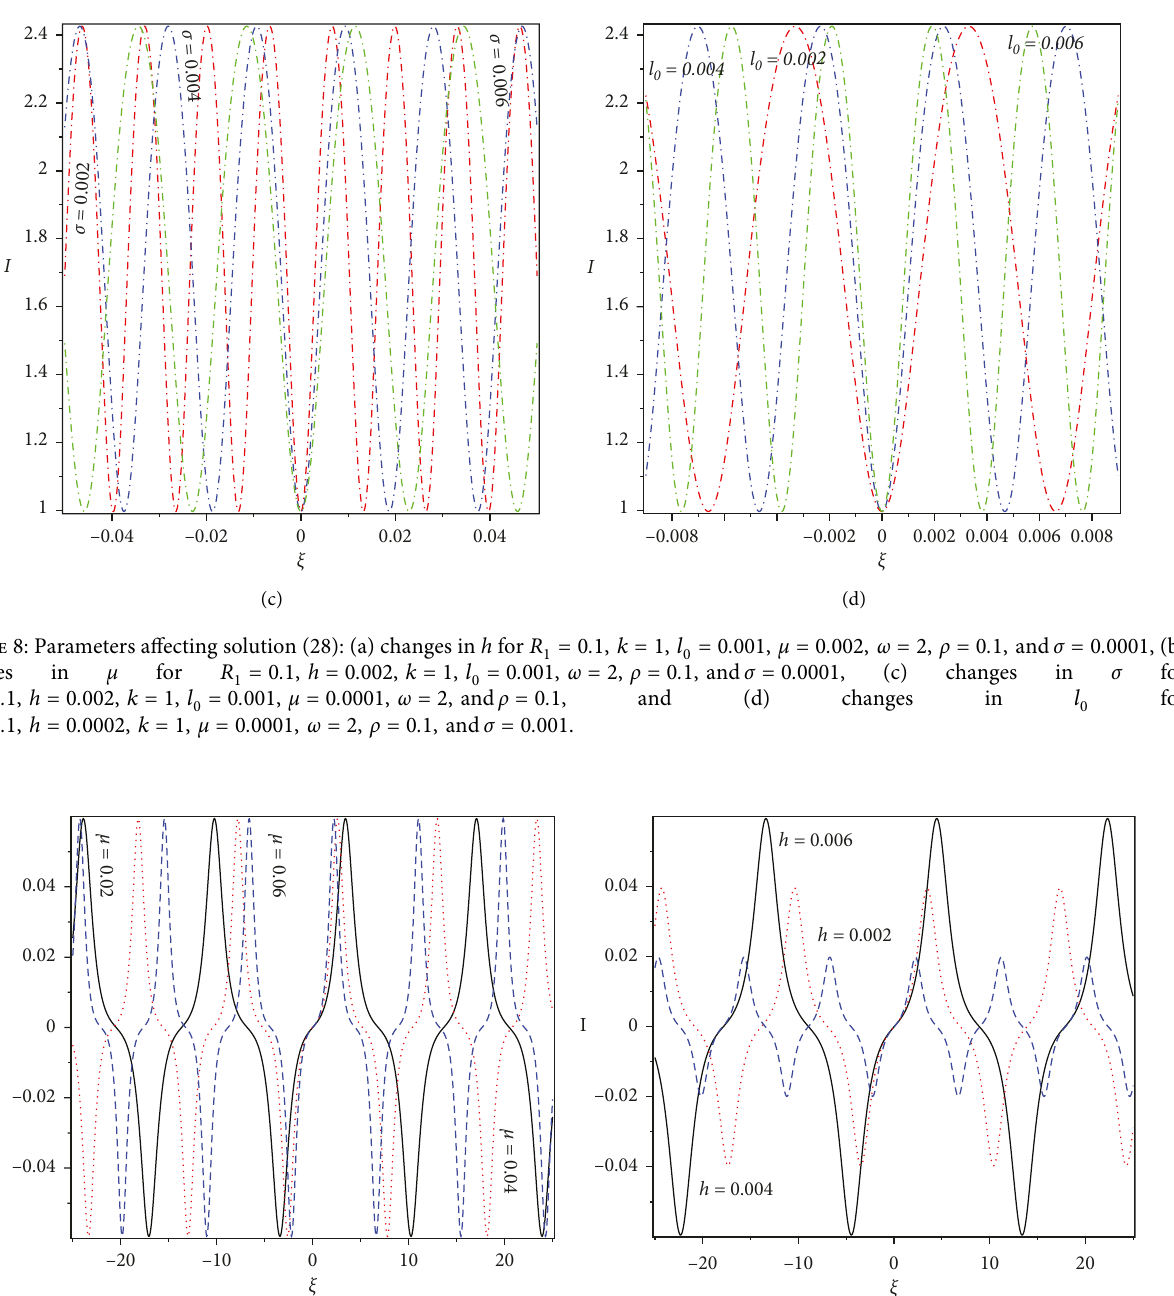
. 01 , α 0 . 8 , h 0 . 006 , k 1 , l 0 0 . 001 , ρ 1 (cid:31) 0 (cid:31) (cid:31) (cid:31) (cid:31) 1 , l 0 0 . 001 , ρ 0 . 00002 , and σ 0 . (cid:31) (cid:31) (cid:31) (cid:31)